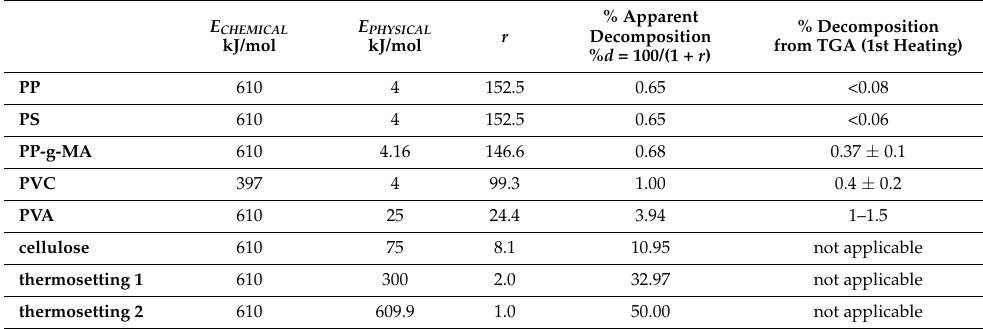
Table 1. % apparent decomposition of various polymers calculated theoretically and % decomposition experimentally observed in the first TGA